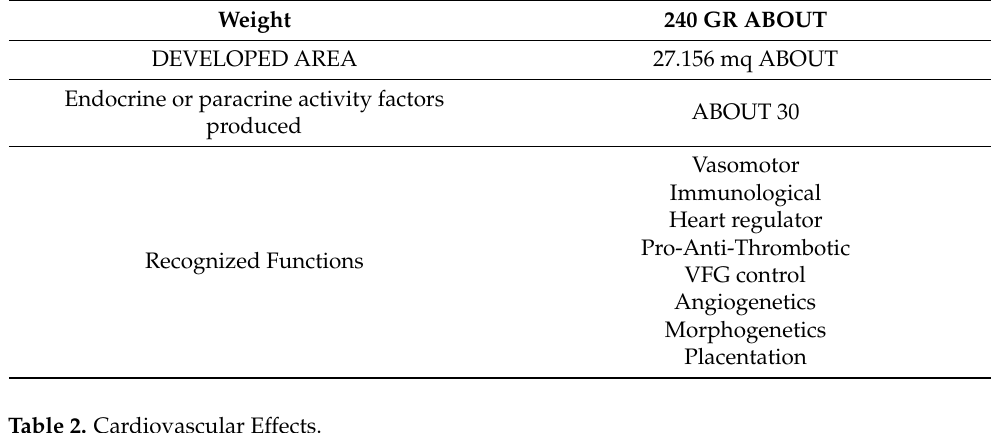
Table 2. Cardiovascular Effects.